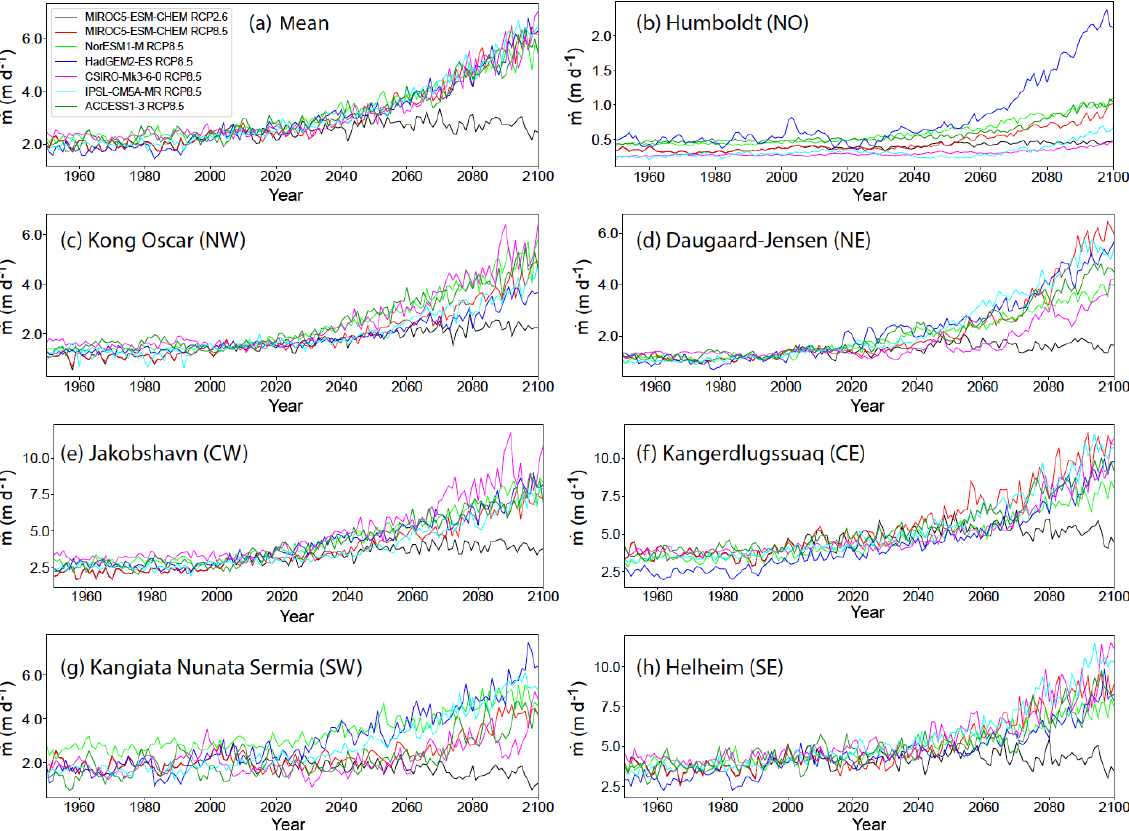
Figure 10. Melt rates in the submarine melt implementation. (a) Mean submarine melt rate over the seven glaciers that are the largest by ice flux in each of the seven regions, for the CMIP5 models and scenarios listed in Table 1. (b–h) Submarine melt rates at the largest glacier by ice flux in each